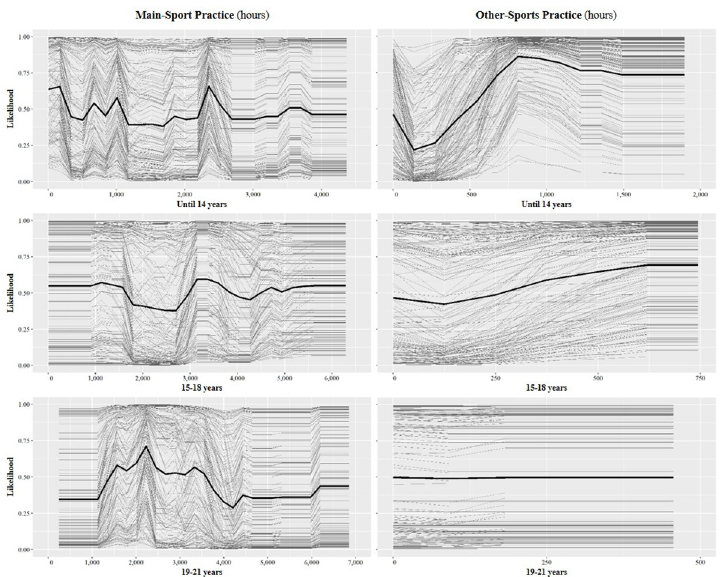
Fig 2. Individual Conditional Expectation (ICE) curves for the features volume of coach-led practice in the athlete’s main sport and coach-led practice in other sports. Bold curves illustrate the mean values. A likelihood value of 0.5 corresponds to chance. Note the different abscissae scale orientations.